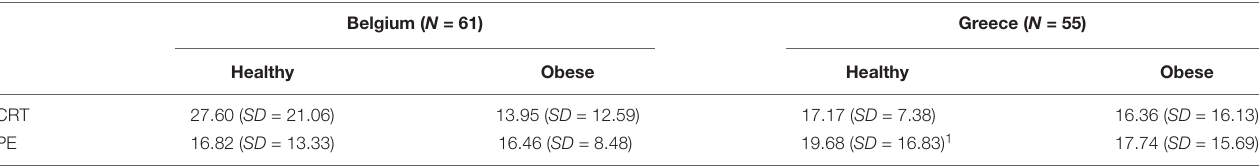
TABLE 2 | Mean consumption in grams.